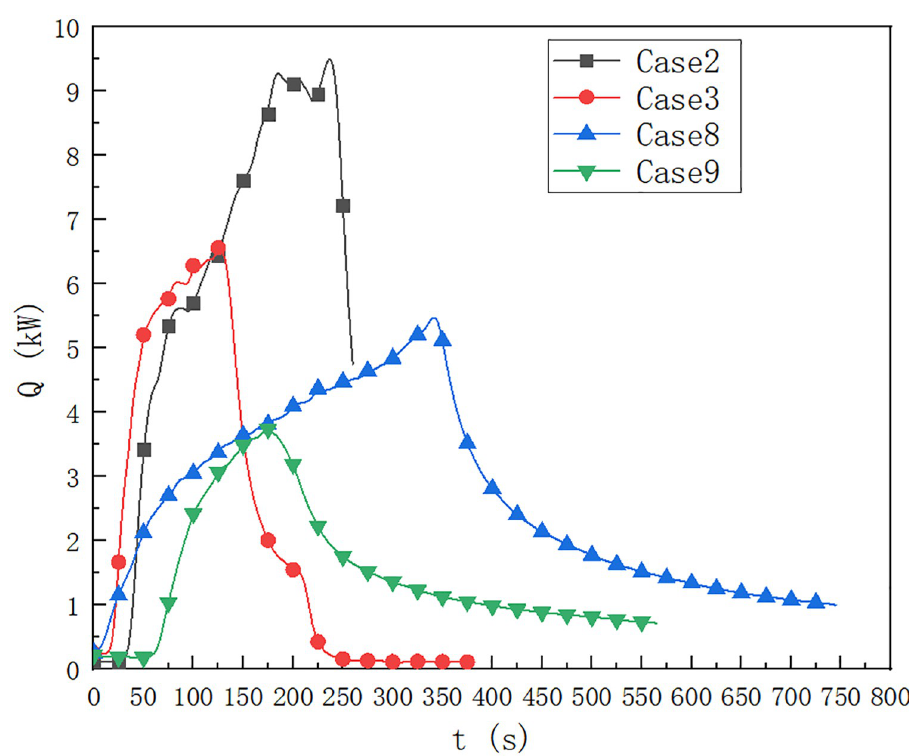
Fig 10. Prediction of fire HRR at 0.5 m from fire source in cable compartment of utility tunnel under cases of 2, 3, 8 and 9.